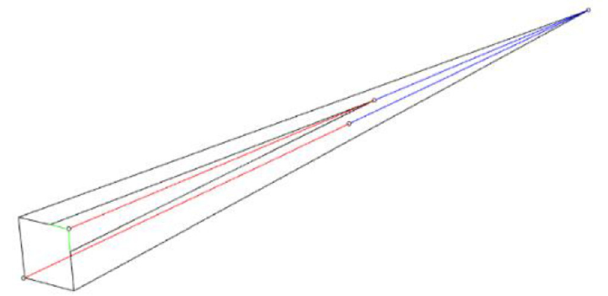
Fig. 15. Schematic of the de fl ection of the center of the correction tool